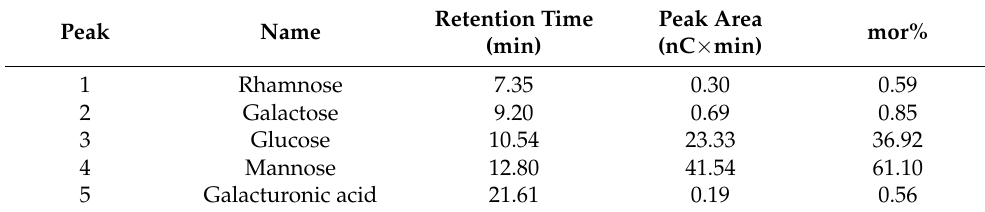
Table 1. The monosaccharide composition of Dendrobium polysaccharide. Peak